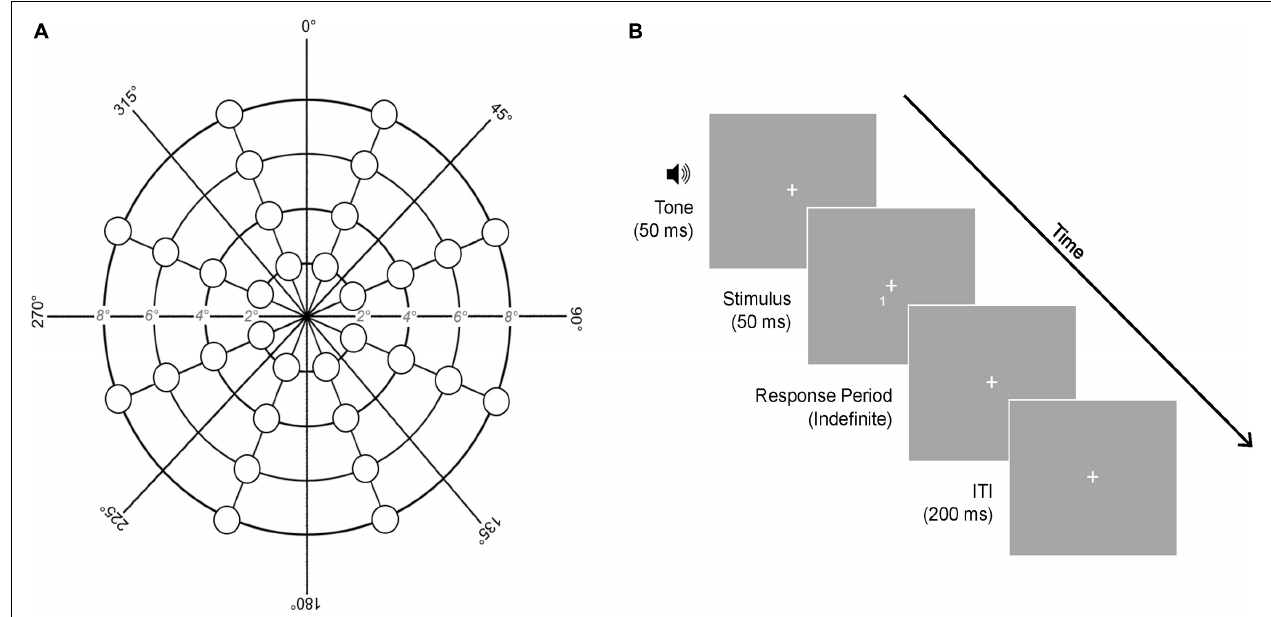
FIGURE 3 | Central vision task. (A) Stimulus presentation locations. (B) Trial structure of the task. Each stimulus was preceded by a 50 ms tone, presented briefly for 50 ms, and followed by an indefinite response period. A 200 ms inter-trial interval (ITI) elapsed between trials. Five stimulus presentations occurred at each of the 32 locations shown, resulting in 160 trials. ms,